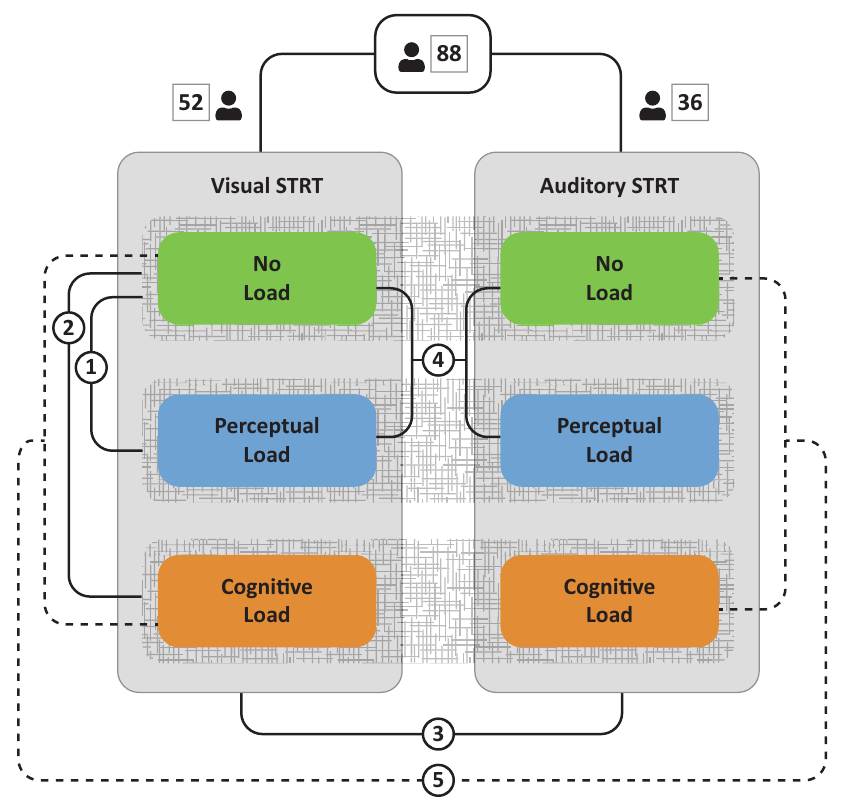
Figure 2. Depiction of the experimental design and contrasts employed in our analyses. After data cleaning, 52 participants were in the visual STRT condition and 36 participants were in the auditory STRT condition. No load, cognitive load, percep- tual load conditions were presented two times each in random order. Contrasts are as follows: 1) main effect of perceptual load irrespective of condition; 2) main effect of cognitive load irrespective of condition; 3) main effect of condition, irre- spective of cognitive load or perceptual load; 4) interaction effect between perceptual load and condition; 5) interaction effect between cognitive load and condition. Except for the interaction between cognitive load and condition, all effects were significant ( p <